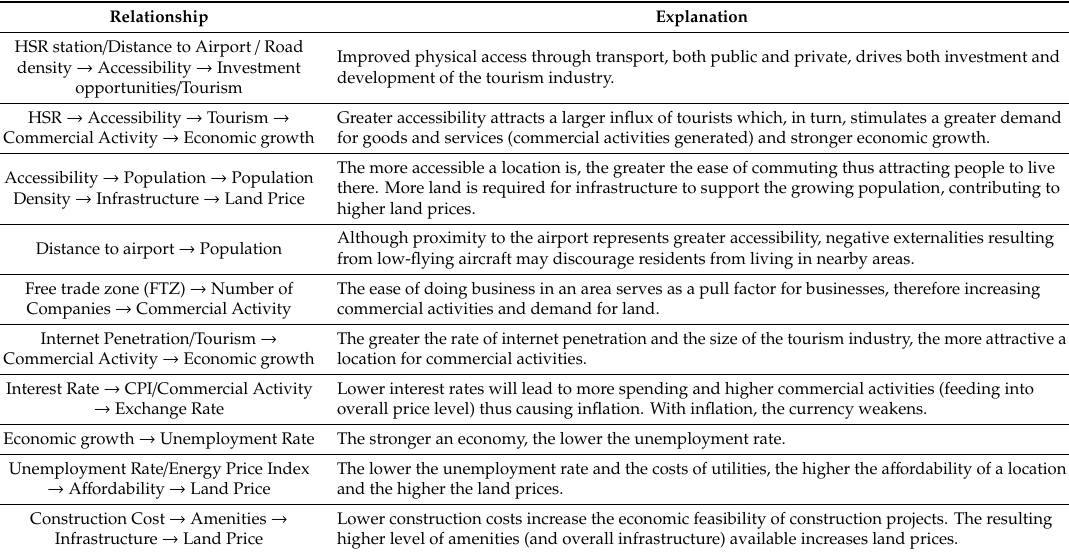
Table 1. Linking up the relationships of the causal loop